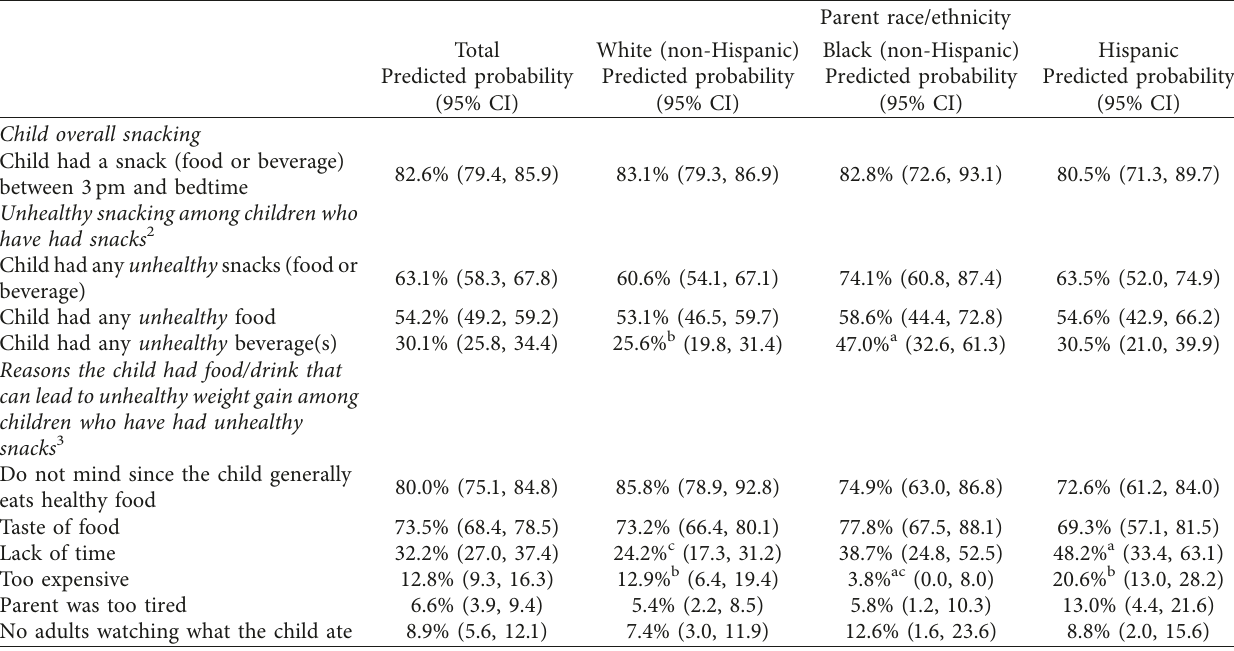
Table 3: Differences in the probability of reported child snacking 1 behaviors, by parent race/ethnicity ( n � 810).